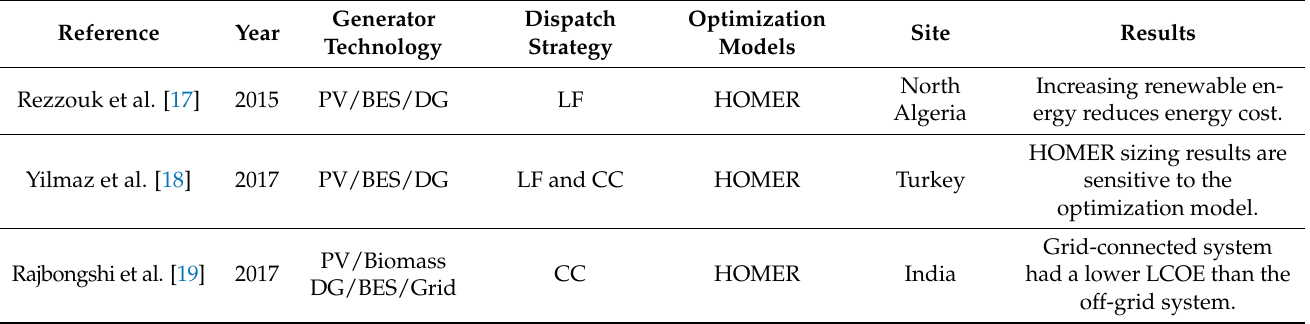
Table 1. Literature review of hybrid energy studies using different HOMER and custom dis- patch